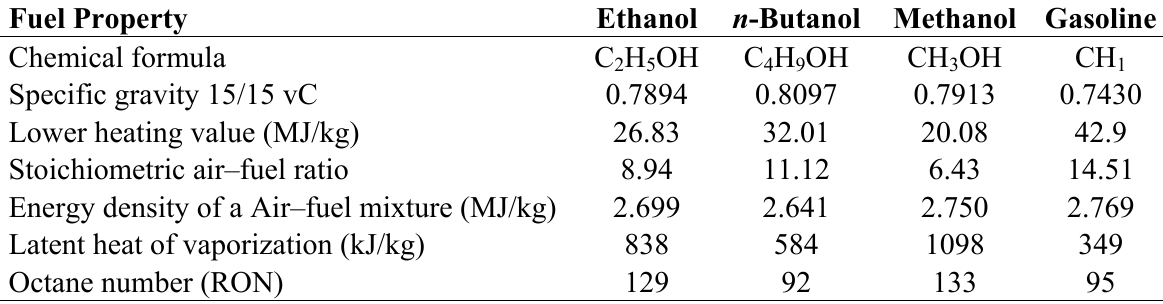
Table 3. Characteristics of test fuels used in this study [13].